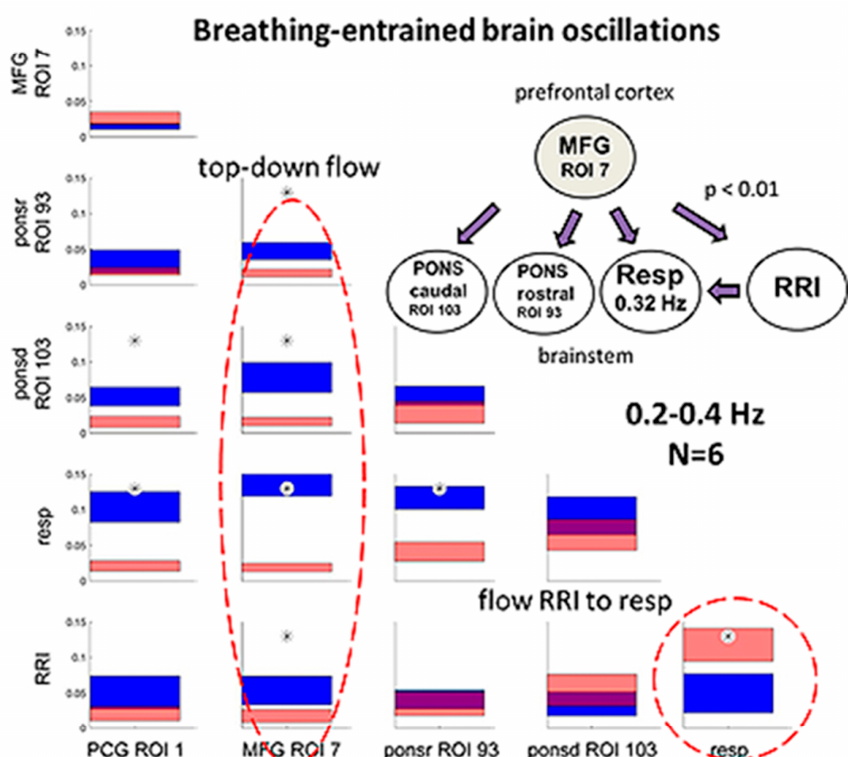
Figure 7. Directed coupling strengths for group 2 (n = 6) with high anxiety and predominant respiration in the 0.2–0.4 Hz frequency band. Each box shows the strength of coupling on the vertical scale. The width of bars is proportional to the mean error. The blue color shows the flow from the signal marked below the given column to the signal marked on the left, and the red color shows the flow from the signal marked on the left to the signal marked below. Violet areas mark an overlap of the two flow directions. Significant differences between couplings of inflow and outflow are marked by asterisks ( p < 0.05). Red stippled ellipses mark the dominant downward flow (on the left) and the information flow from RRI to respiratory signal (on the right). The insert in the right upper corner indicates a diagram with the most important downward flows. Less pronounced flows, especially upward flows, are not shown.